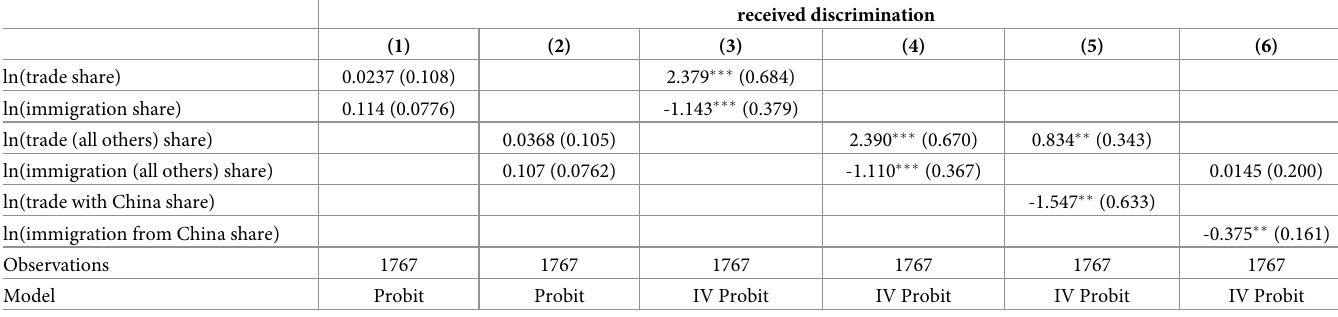
Table 6. Discrimination, openness to trade and immigration